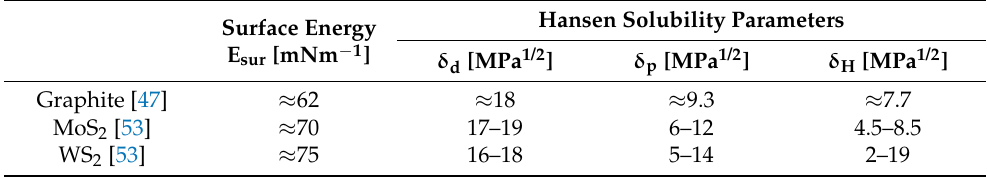
Table 2. Surface energy and Hansen solubility parameters for graphite, MoS 2 , and WS 2 . Surface